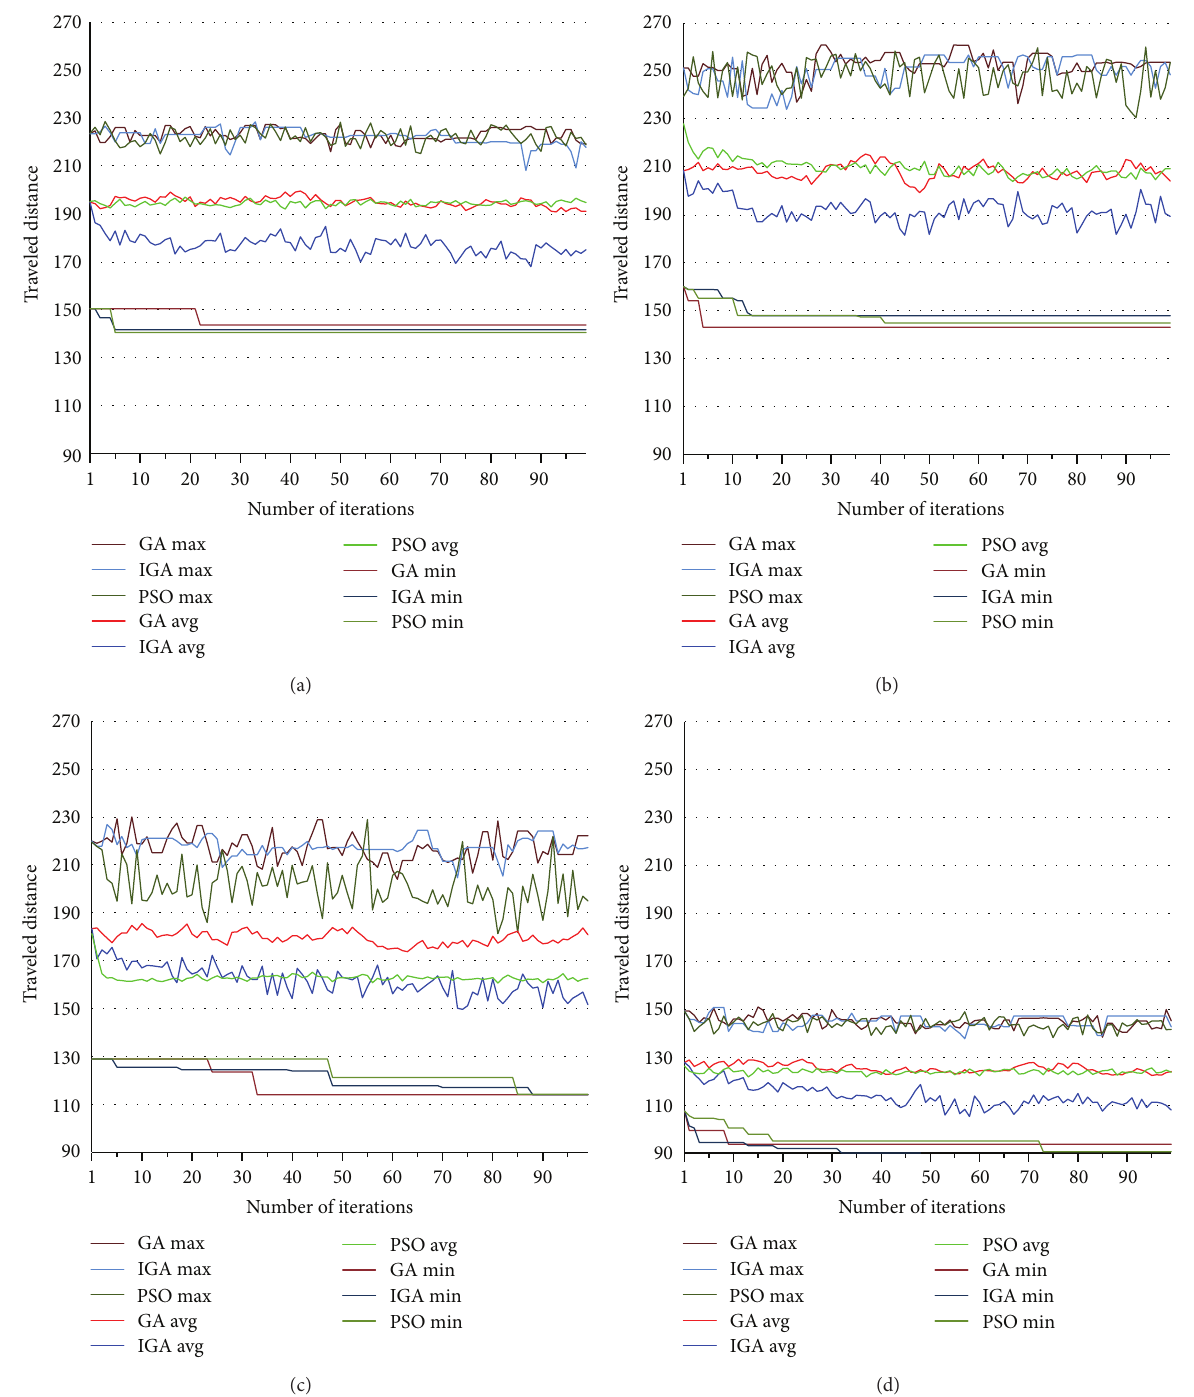
Figure 11: The shortest traveled distance for simulation results for Case 5. 20 goods overlap by GA, IGA, and PSO. (a) Goods type A, (b) goods type B, (c) goods type C, and (d) goods type